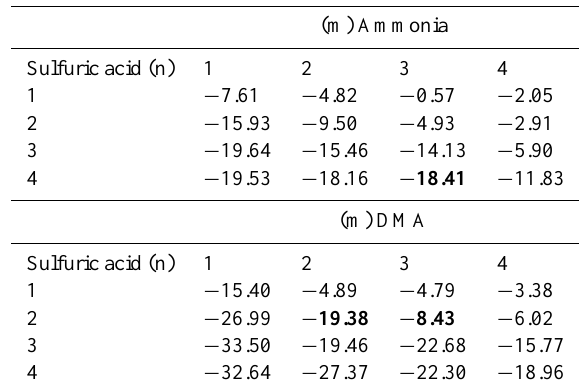
Table 4. Gibbs free energy for the reaction ((H 2 SO 4 ) n (NH 3 /(CH 3 ) 2 NH) m − 1 + NH 3 /(CH 3 ) 2 NH → (H 2 SO 4 ) n (NH 3 /(CH 3 ) 2 NH) m ) in kcalmol − 1 at